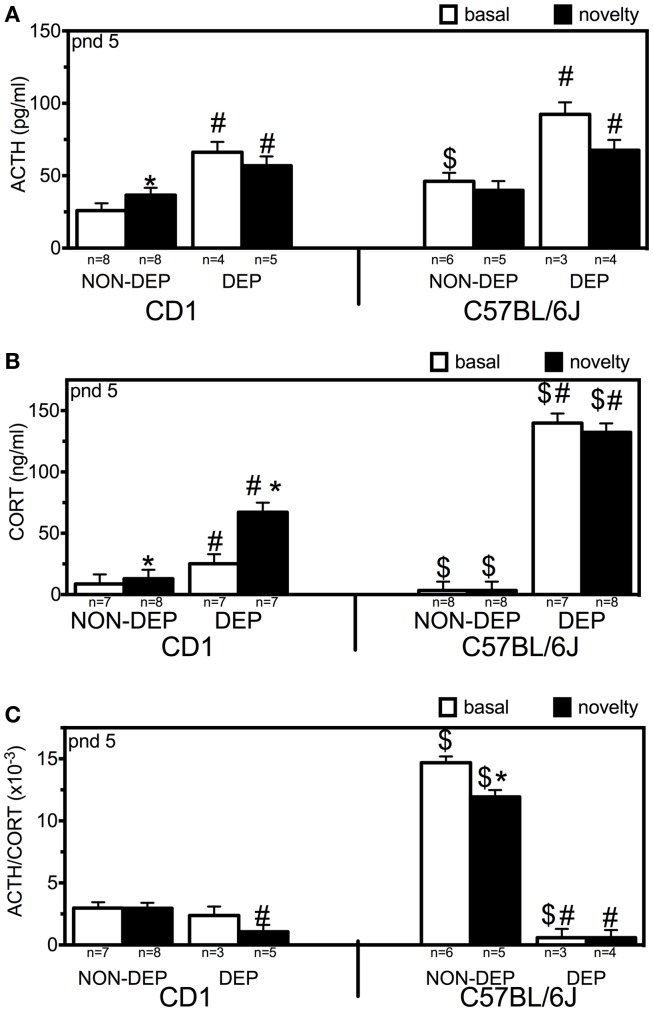
ACTH [(A); picogram/milliliter], corticosterone [(B); CORT in nanogram/milliliter] blood plasma levels, and their ratio [(C); ACTH/CORT] of non-deprived (NON-DEP) and 24 h deprived (DEP) pups measured at basal conditions (basal; white bars) or after 30 min of novelty exposure (novelty; black bars) at postnatal day (pnd) 5. Data represent mean ± SEM. * vs. basal, # vs. NON-DEP, $ vs. CD1. Significance level was set at p = 0.05.